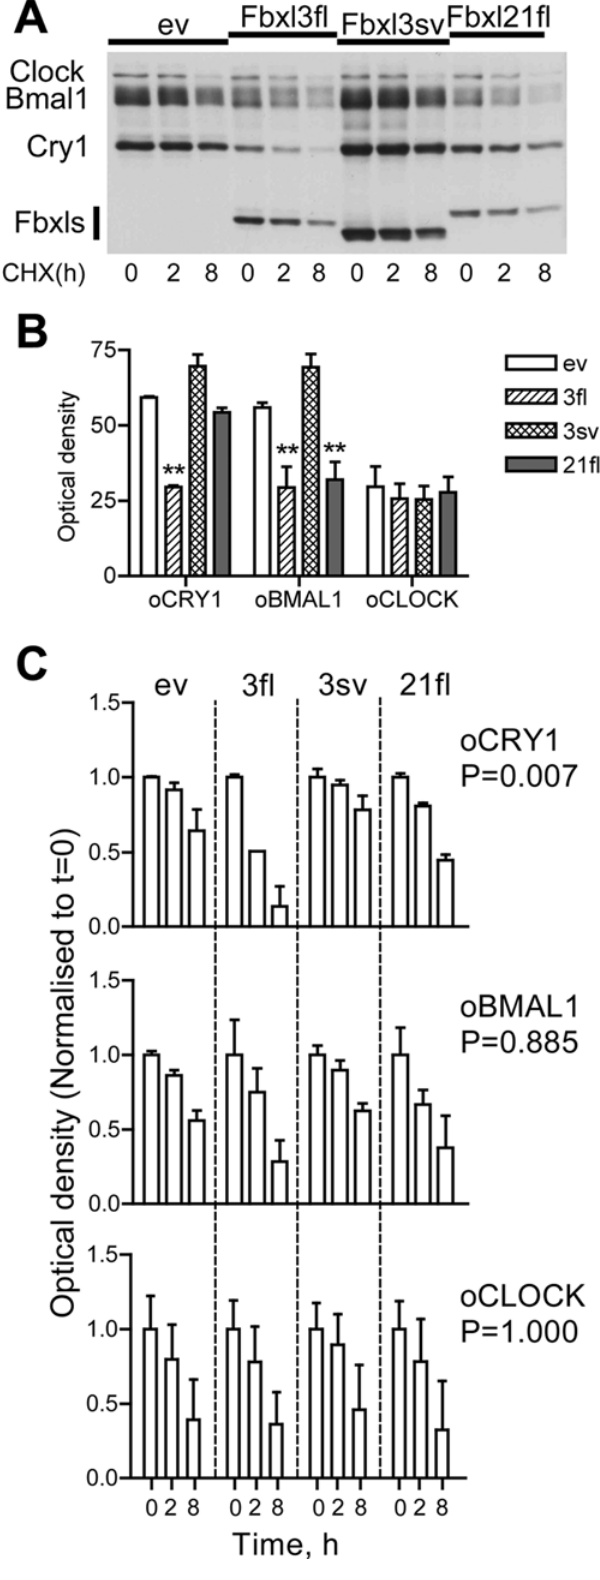
Figure 3. Fbxl21 and Fbxl3 promote degradation of ovine CRY1 and BM1. A . COS7 cells were transfected with oCry1, oBm1 and oClk, and an oFbxl expression vector as indicated above each lane. Extracts were made at the start of cycloheximide (CHX) treatment